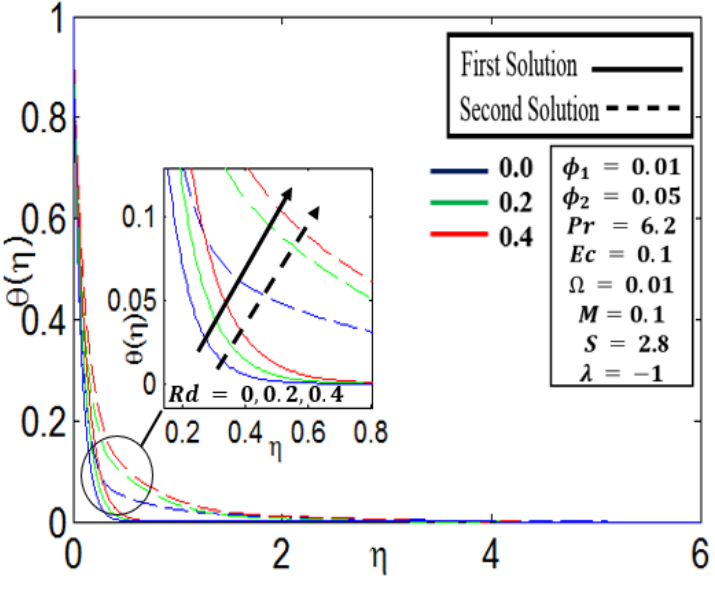
Figure 7. Profile of 𝜃(𝜂) for different 𝑅𝑑 parameters.